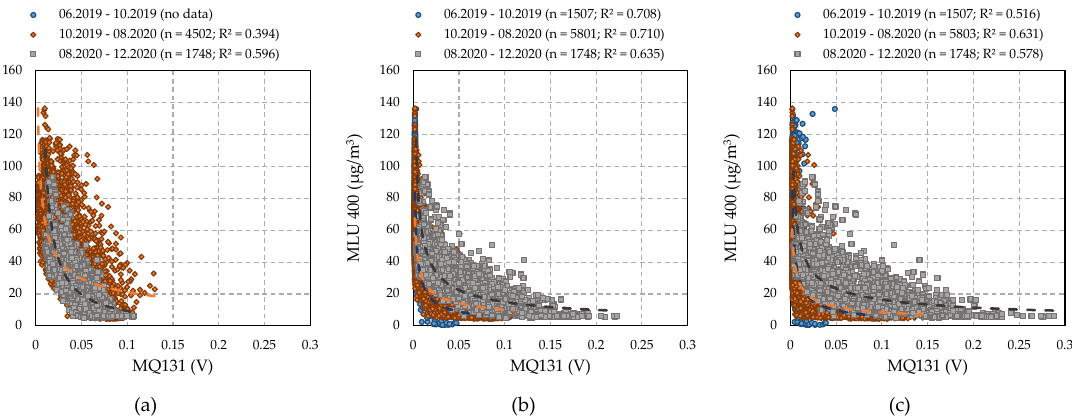
Figure 7. Results of power-law fittings for 1 h averaged data from MQ131: ( a ) unit No. 1; ( b ) unit No. 2; ( c ) unit No. 3. Dashed lines denote the fitted curves. n—number of samples used for the fitting, R 2 —coefficient of determination.